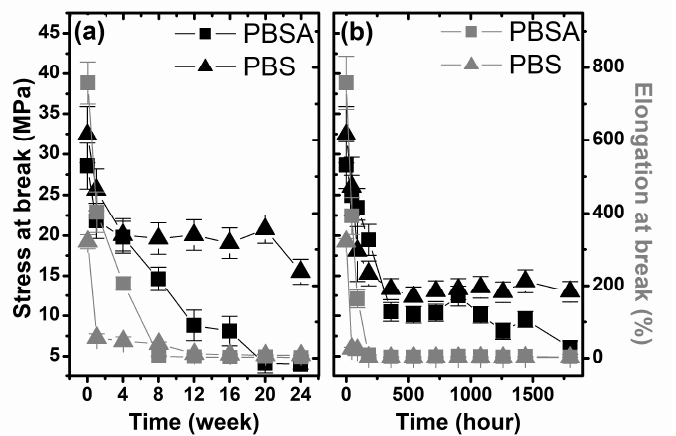
Figure 3. The changes in the mechanical properties of the studied samples during degradation in selected environments: ( a ) biodegradation in soil and ( b ) artificial weathering.